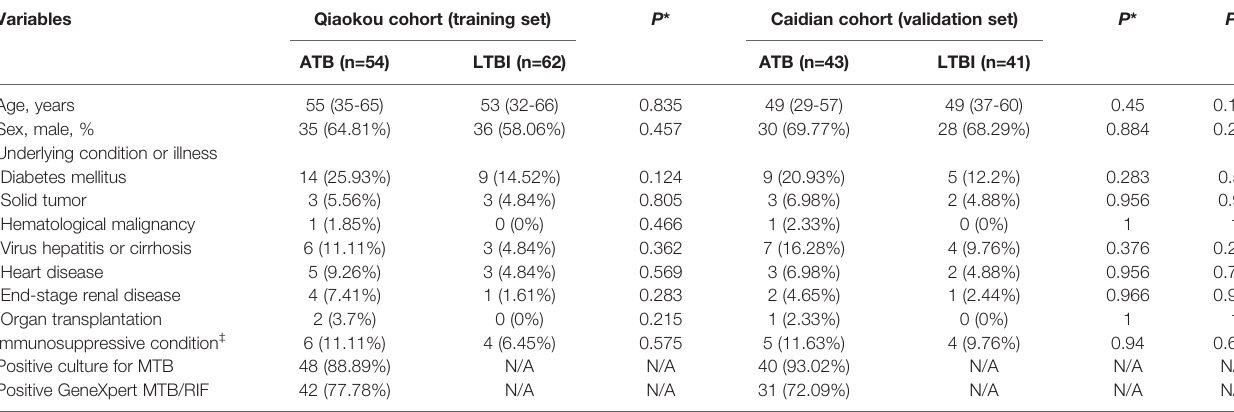
TABLE 1 | Demographic and clinical characteristics of recruited participants.